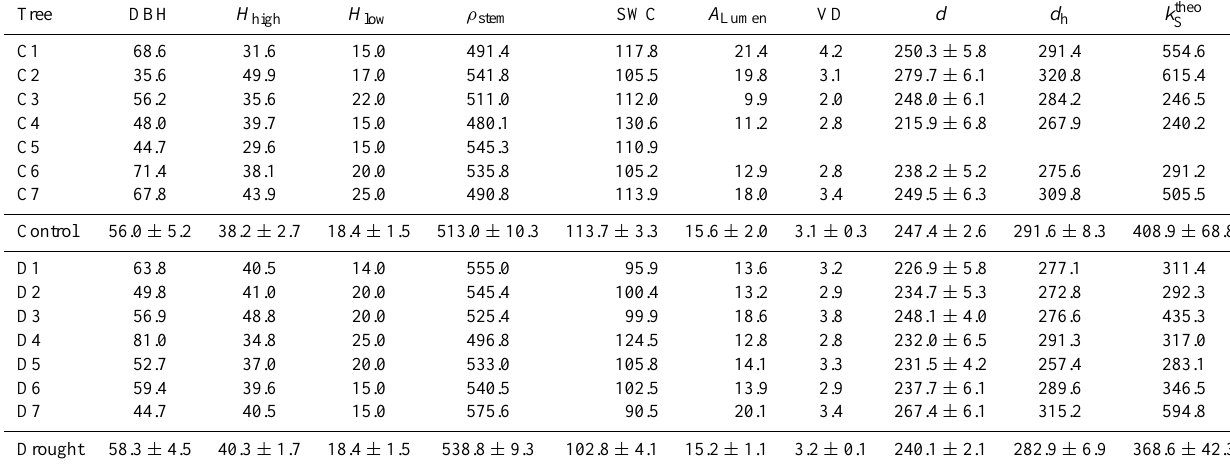
Table 2. Biometric characteristics of 14 individual C. acuminatissima trees and morphological, anatomical and hydraulic characteristics of the trunks at 1.5m height. Diameter at breast height (DBH, cm), total tree height ( H high , m), canopy base height ( H low , m), stem wood density ( ρ stem , kgm − 3 ) , saturated water content of stem wood (SWC, %), vessel lumen area ( A Lumen , %), vessel density